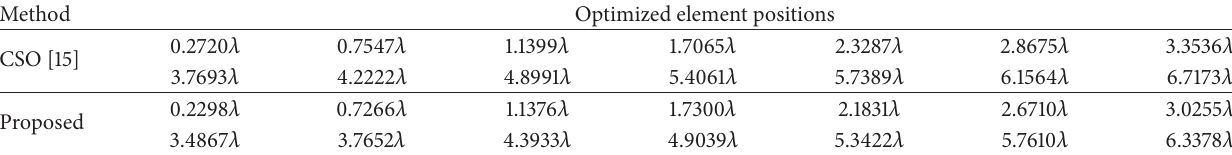
Table 3: Optimized positions of the positive half of the 28-element array of Example 2 .